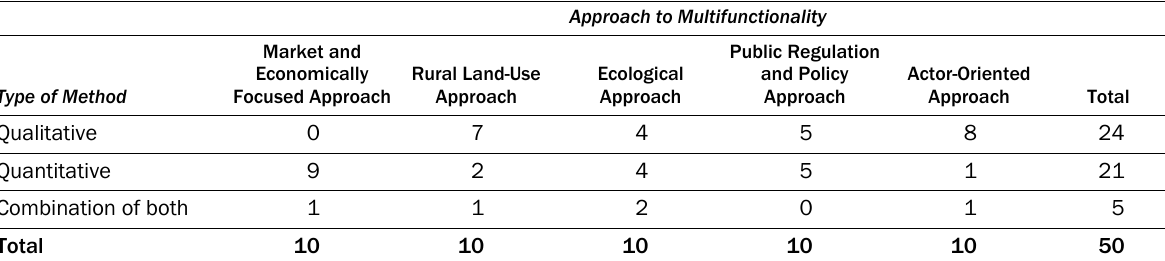
Table 1. Type of Method Used by Approach to Multifunctionality